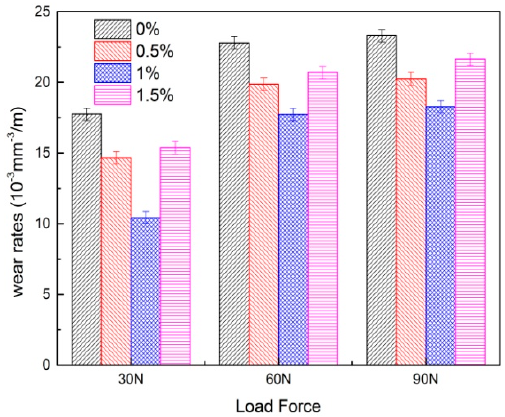
Figure 7. Wear rates of the tested alloy under different load force.